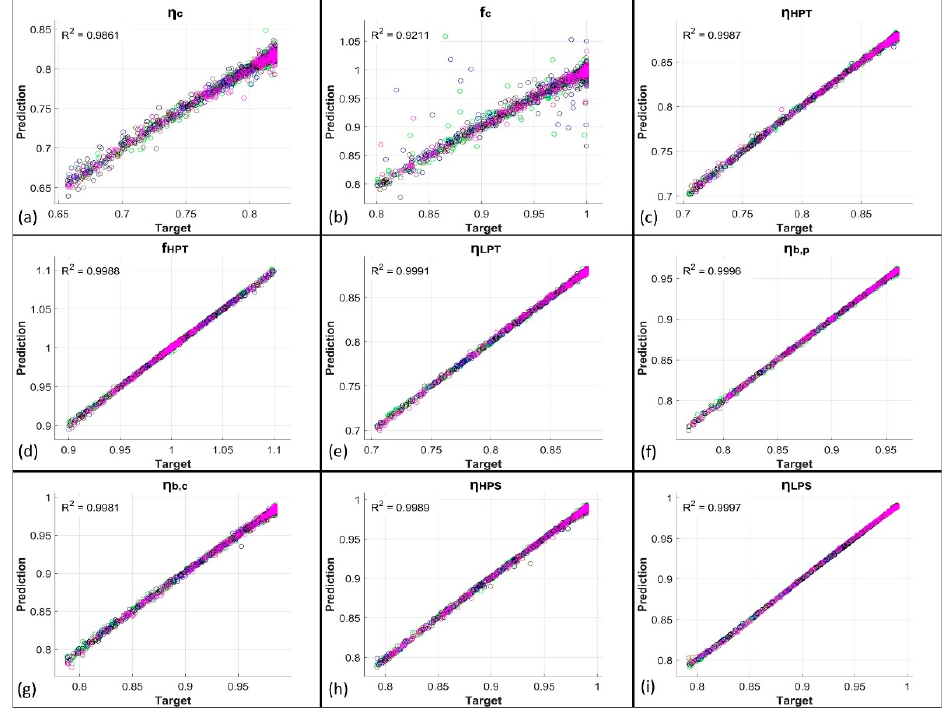
Figure 7. ( a – i ) Comparison between FFNN predictions and targets about the PPs related to the multi-component degradation condition. Grey: START-A; brown: START-B; green: MAXPOW-A; blue: MAXPOW-B; black: MAXDUR-A; magenta: MAXDUR-B.